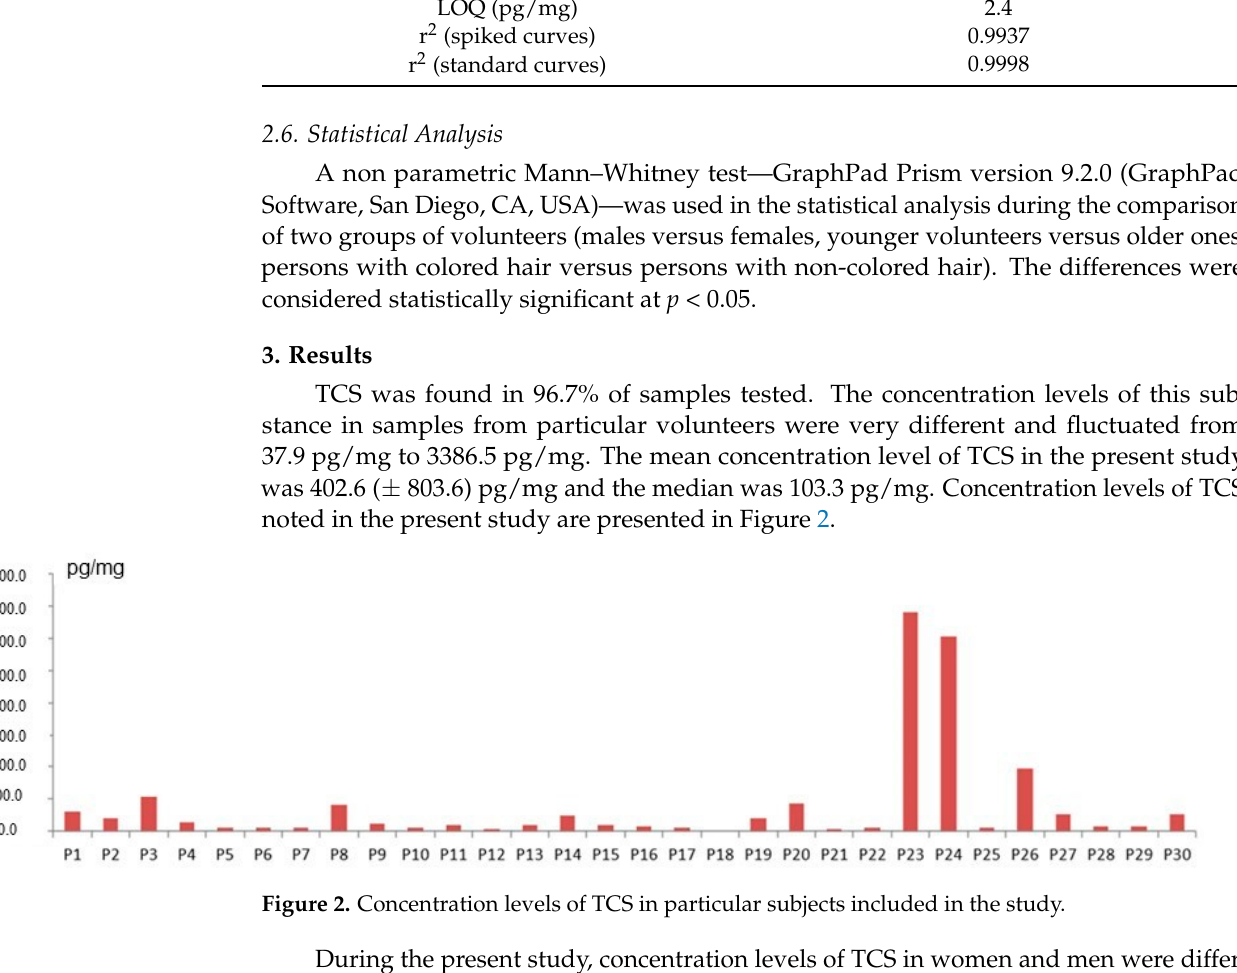
Table 2. Validation parameters of the applied methodology.